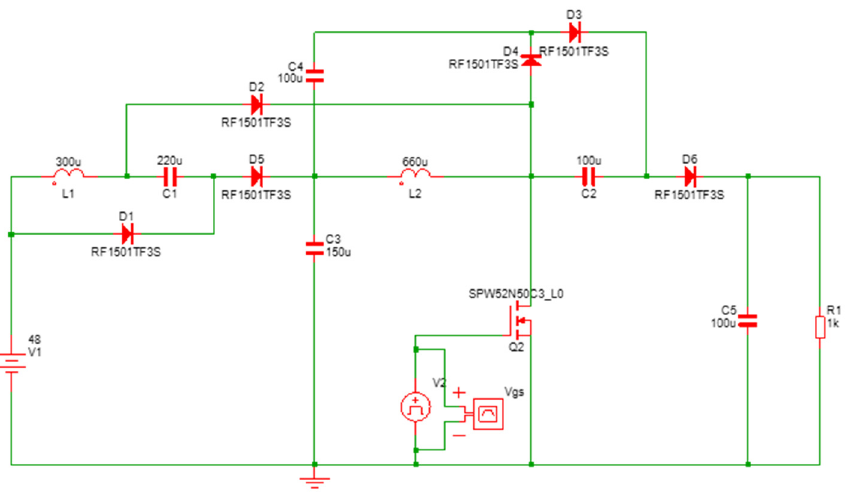
Figure 12. Pictorial representation of proposed circuit simulated in SIMPLIS software. Simulation Results of the Proposed Boost Converter at Duty d = 0.4, Output Power 150-W Though the actual duty cycle was considered 0.4, in the experimental section, the MOSFET was not turned off at exactly at the duty cycle of 0.4; instead, it was turned off at duty 0.402 due to the Miller effect. So, the simulation was carried out by selecting the duty cycle of 0.402 and the corresponding theoretical output voltage, referring to Equation (22) was calculated as 428 V. However, due to the presence of a diode forward voltage drop the actual voltage deviates, and as a result the real voltage gain is always lower than the ideal gain. From the datasheet of the diode’s model, the forward voltage drops (i.e.,